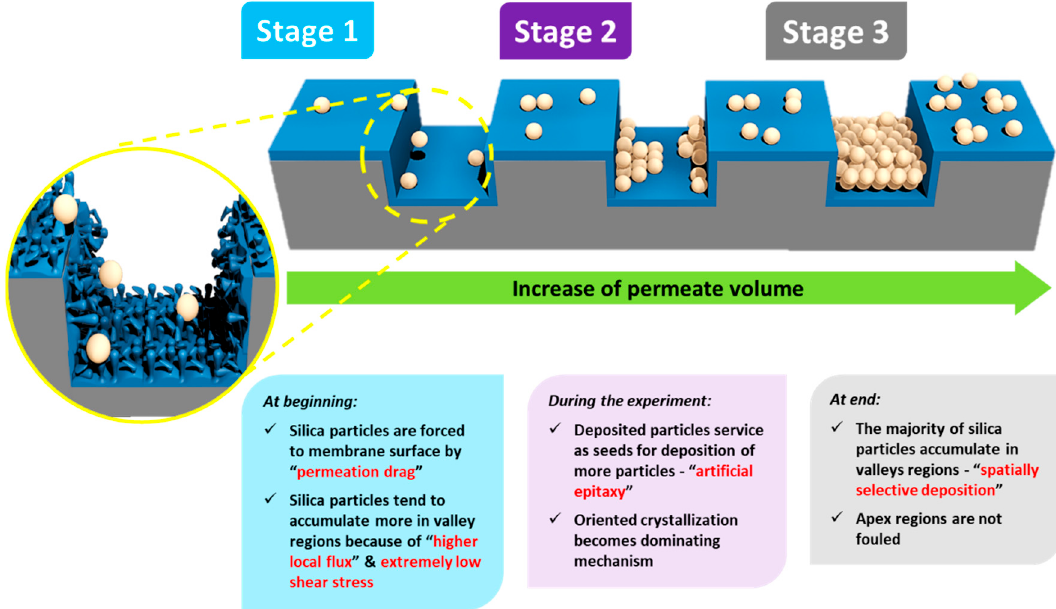
Figure 4. Schematic illustrations for a suggested mechanism interpreting the spatially selective silica microparticle deposition phenomenon on micro-patterned PA TFC membranes in unstirred dead-end filtration conditions.